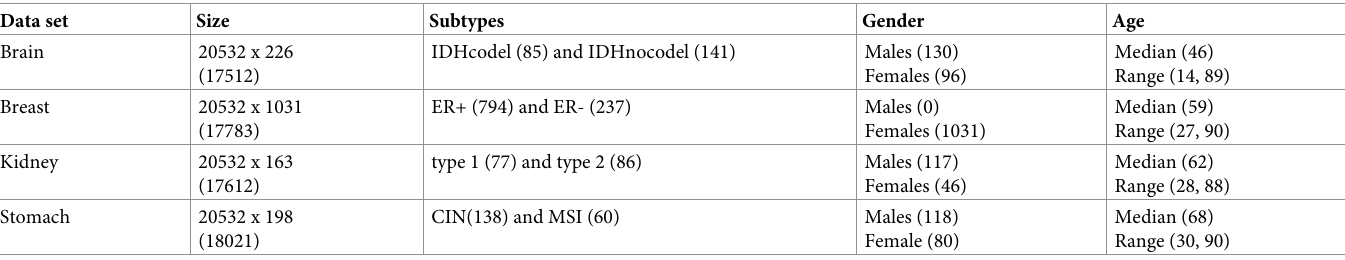
Table 1. Summary of data